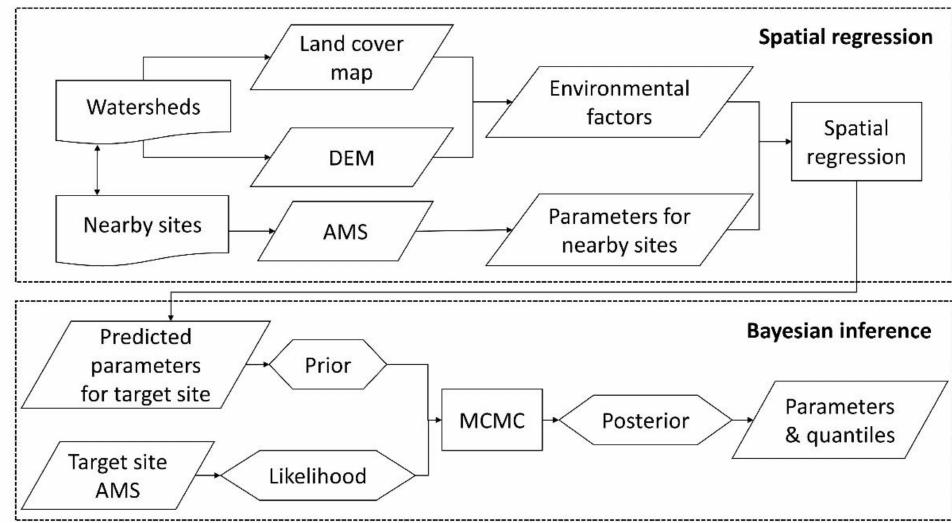
Figure 1. Flowchart of the BLP3-SP